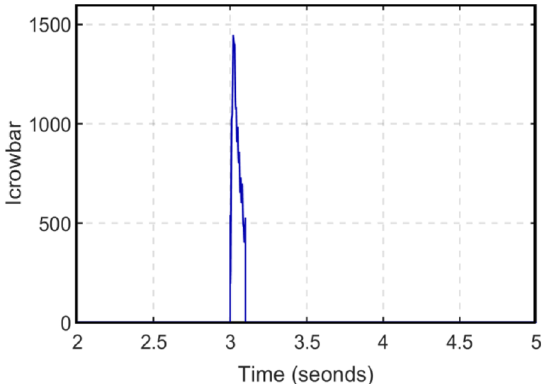
Fig. 16 Variation of the crowbar current